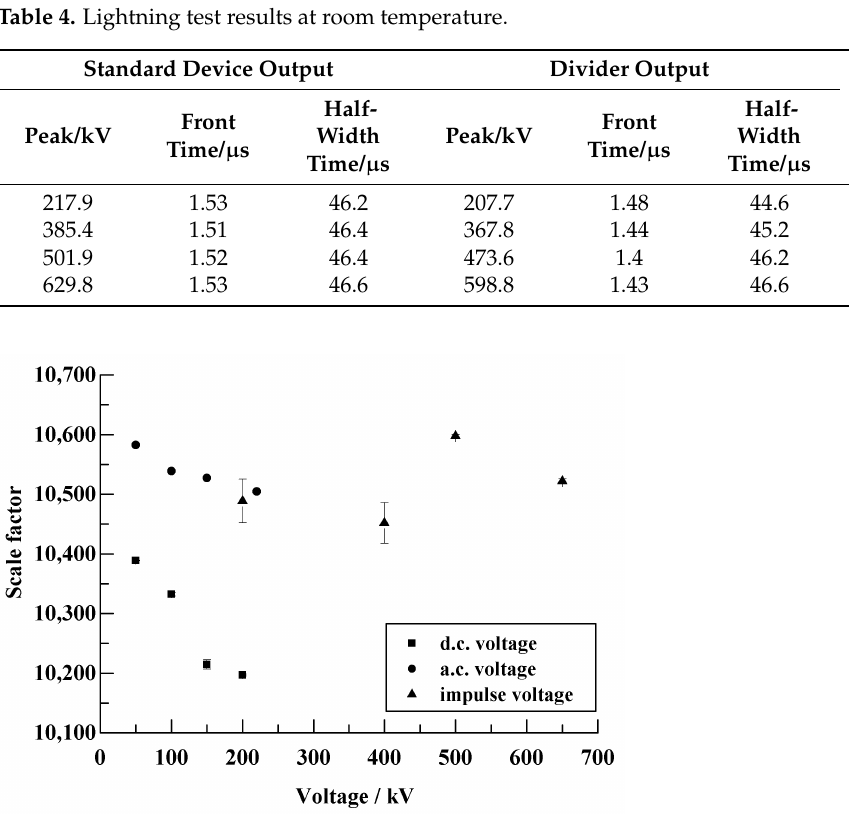
Figure 13. Test results of DC, power frequency and lightning impact voltage ratio at room temperature.